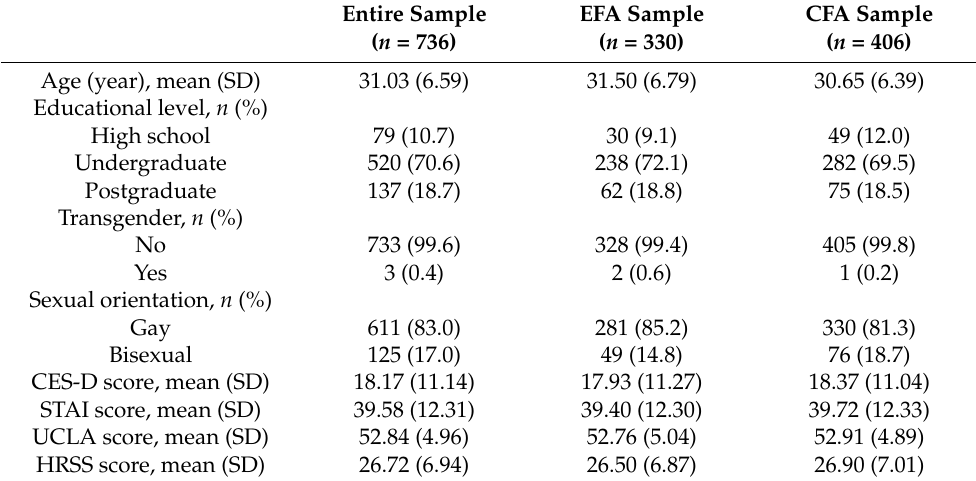
Table 1. Participant characteristics.